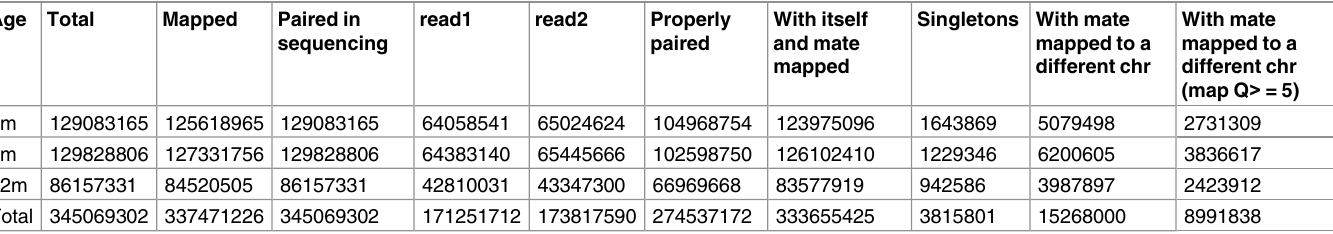
Table 2. Transcriptome mapping profile of liver tissue from the Polish Red cattle breed aligned to bovine referenceUMD3.1 genome assembly. Age Total Mapped Paired in